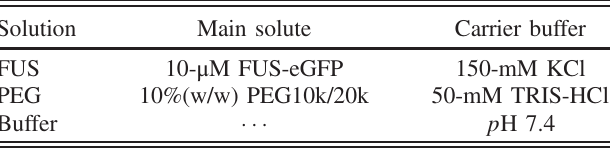
TABLE II. Solution content of syringes used in microfluidic experiments for the FUS-PEG